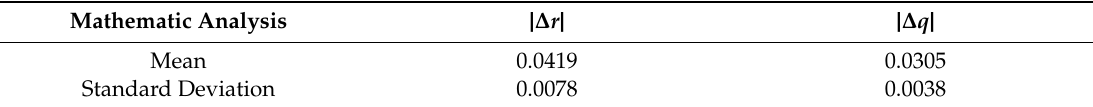
(cid:12) (cid:12) (cid:12) (cid:12) (cid:12) ∆ q (cid:12) .